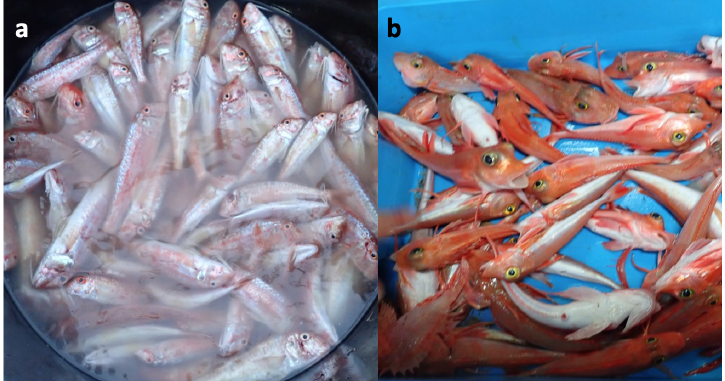
Figure 1. A presentation of the traditional mixture that is made by fishermen in the Catalan coast: ( a ) red mullets, and ( b )